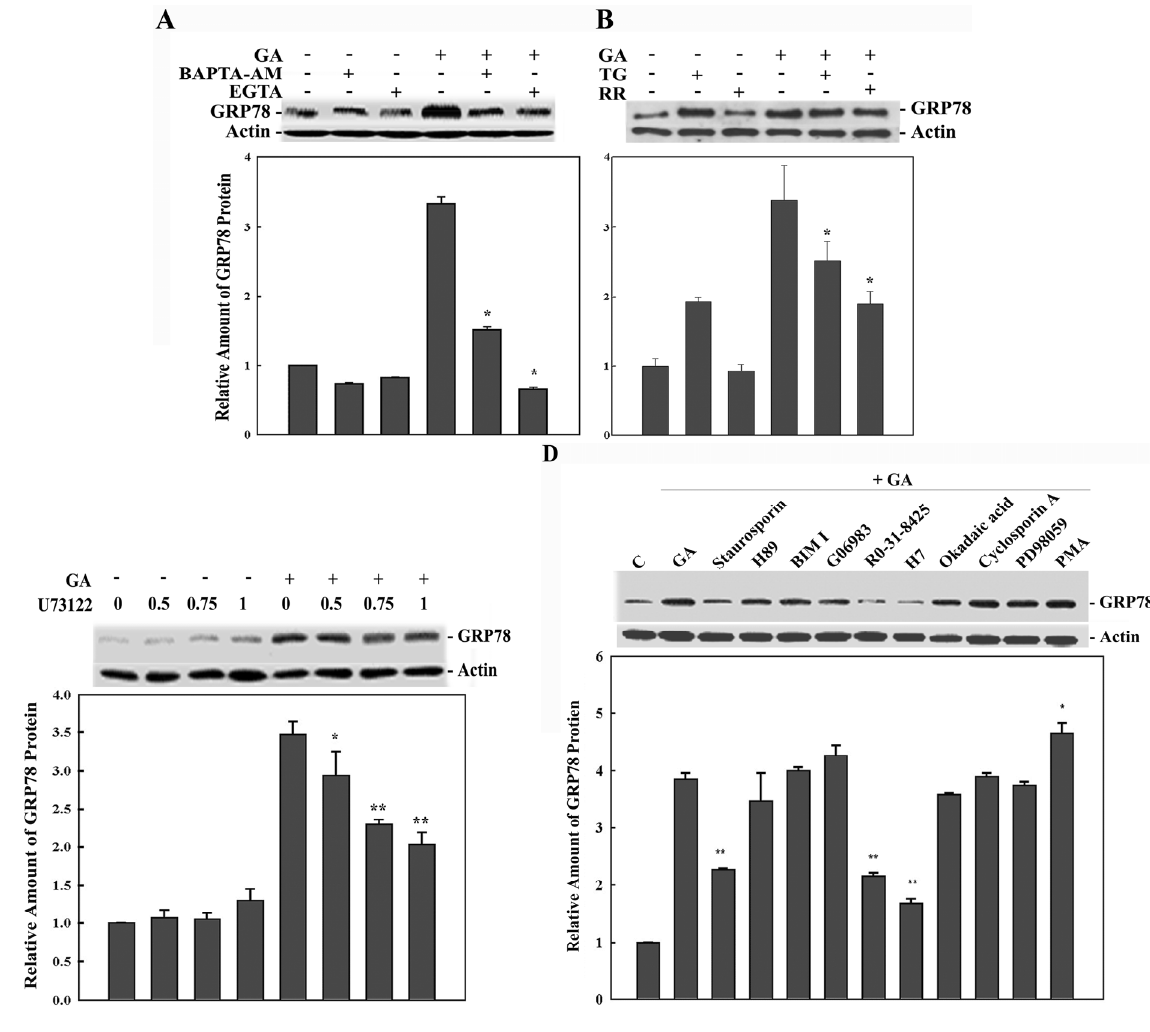
Figure 3. Involvements of calcium, PLC and PKC in GA-induced GRP78 expression. Cells were pre-incubated for 1 h with BAPTA-AM, EGTA ( A ); TG or RR ( B ) and followed by GA treatment for 6 h. Whole cell lysate was subjected to Western blotting. β -actin served as a loading control. The data represent the means ± SD of three independent experiments; * p < 0.01, compared with GA treatment only; ( C ) Cells were exposed to various concentrations of U73122 for 1 h and, then, treated with GA for 6 h; ( D ) cells were incubated for 1 h with 1 µM staurosporin, 10 nM H89, 20 nM bisindolylmaleimide I, 10 µM Go6983, 20 µM Ro-31-8425, 40 µM H7, 60 nM okadaic acid, 50 nM cyclosporin A, 50 µM PD98059 or 1 µM phorbol 12-myristate 13-acetate and followed by GA treatment for 6 h in the presence of the drugs. The samples were processed for Western blotting, followed by quantitative analysis. Bar graphs represent the means ± SD of three independent experiments; * p < 0.05, ** p < 0.01, compared with the treatment with GA